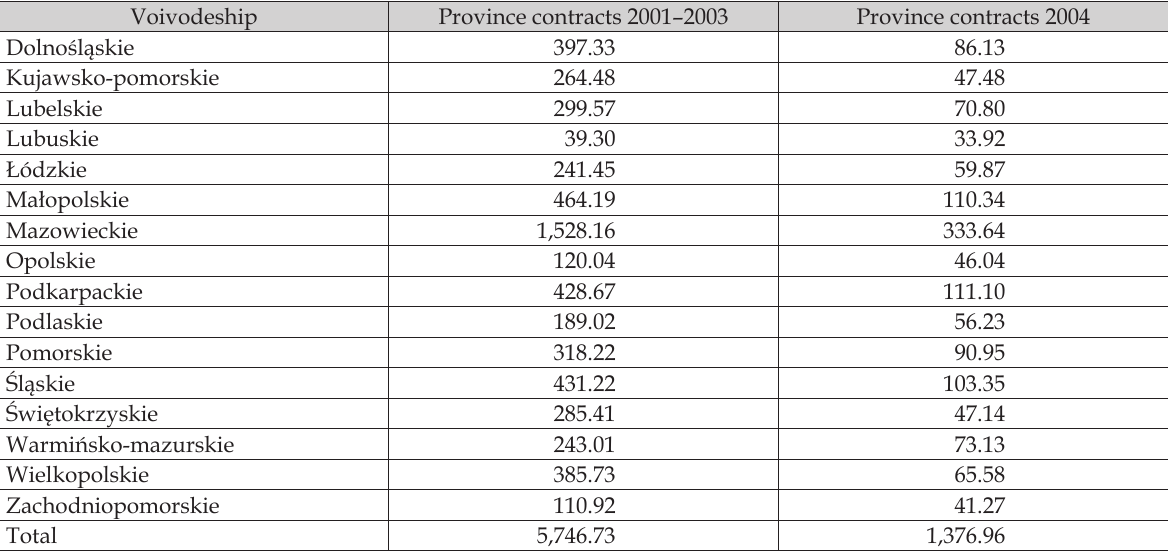
Table 1. Means spent under province contracts in the pre-accession period (in million PLN 4